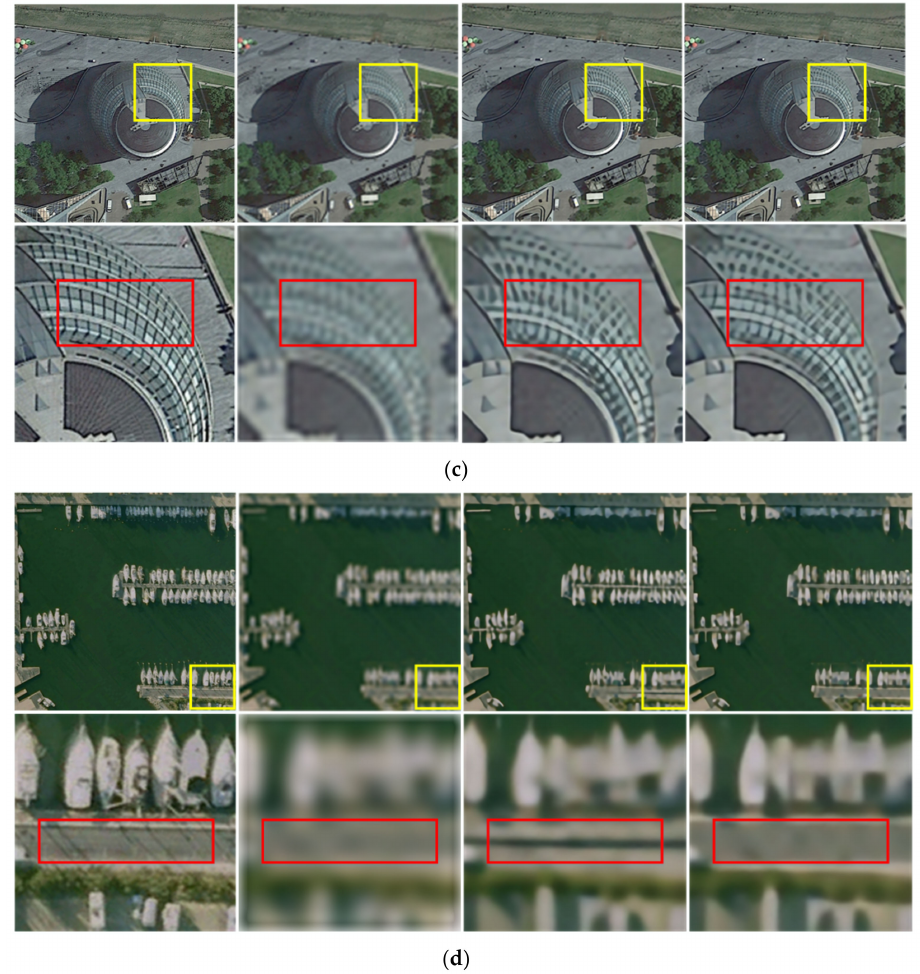
Figure 11. Comparison of the reconstruction effect of the PMSRN with different training sets (DIV2K and AID) in each group of images for all r values. (Left to right) HR, Bicubic, PMSRN (DIV2K), and PMSRN (AID) images. Compared with the other methods, the SR image obtained using the PMSRN (AID) is closer to the HR. The up-sampling factors r value is ( a ) 2, ( b ) 3, ( c ) 4, and ( d )